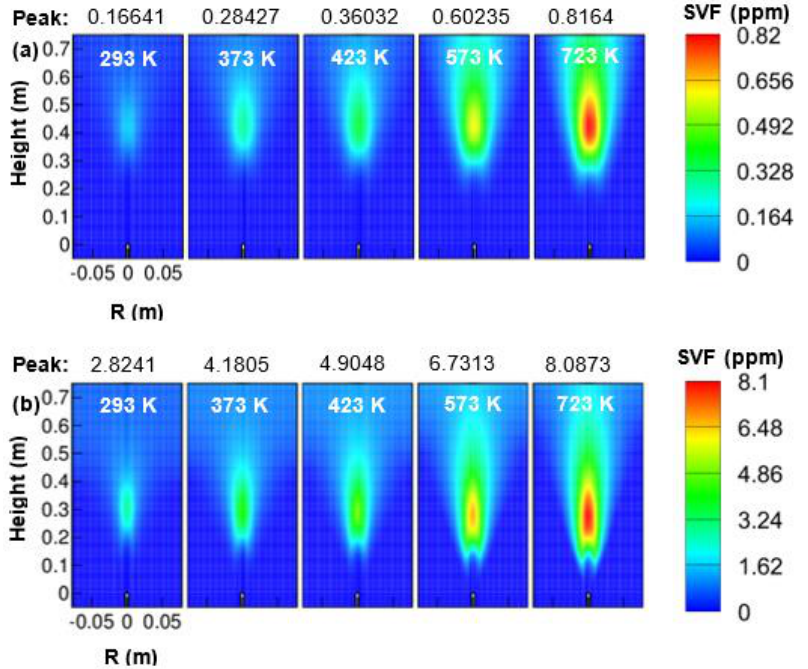
Figure 10. Contours of soot-volume-fractions (SVF) as a function of air temperature; ( a ) 1 atm, and ( b ) 3 atm.